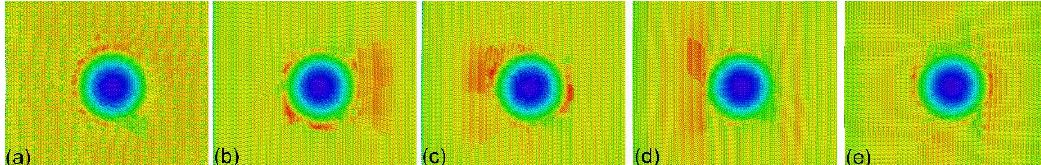
7 of 8 Figure 7. Representative dislocation–TB interactions. Inclination angle: ( a ) 26°; ( b ) 45°; ( c ) 64°; and ( d ) 90°. Atoms are colored according to their CNA values, and perfect FCC atoms are not shown. Figure 8 presents the surface morphology of the indented twinned Al after the completion of